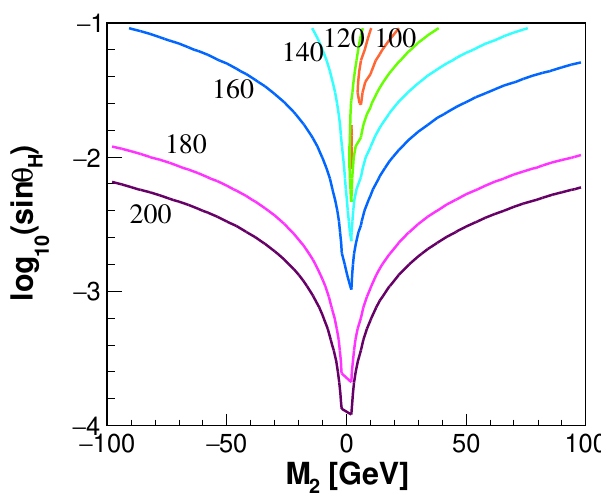
Figure 10 . The projected 95% CL exclusion reach for the W(cid:13) channel for various values of m 5 (in GeV), as a function of M 2 and s H . The region below each line can be excluded with 300 fb (cid:0) 1 of data at the 14 TeV